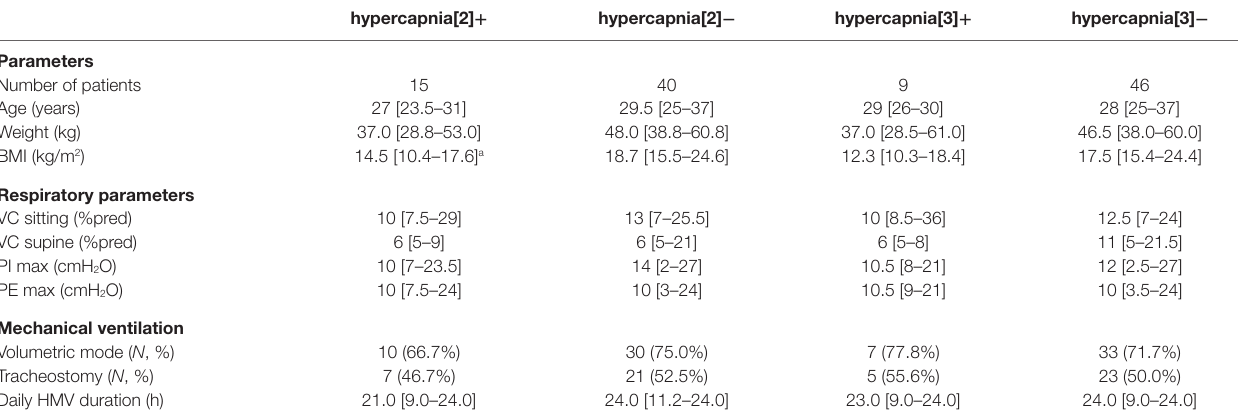
TaBle 2 | Disease severity according to the study